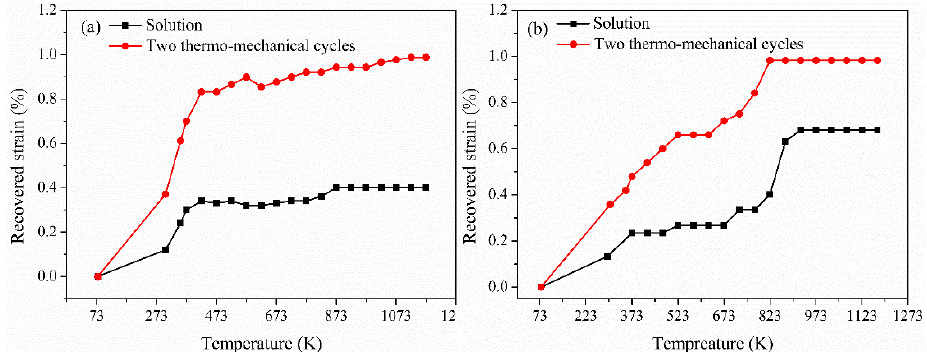
Figure 3. Recovered strains of solution-treated specimen and the one subjected to two thermomechanical cycles as a function of step-heating temperatures after 2.5% strain ( a ) and 10% strain ( b ) at 77 K.